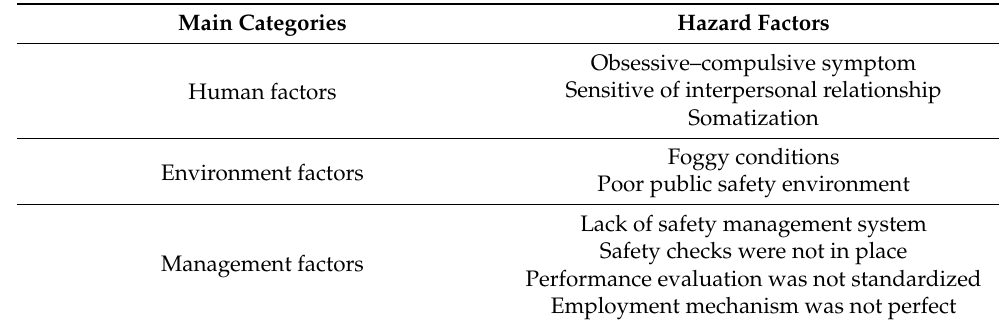
Table 4. Hazard factor division of “Construction organization work was not in